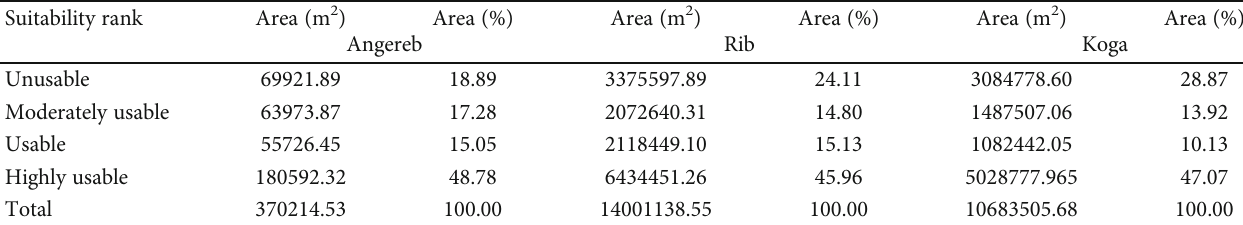
Figure 6: Overall suitability map of fl oating solar PV. Table 6: Water surface area usability for fl oating solar photovoltaic in